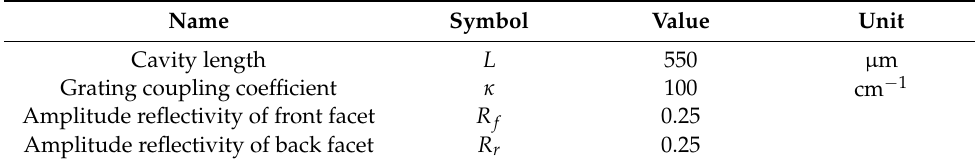
Table 2. Cavity parameters of the DFB laser.